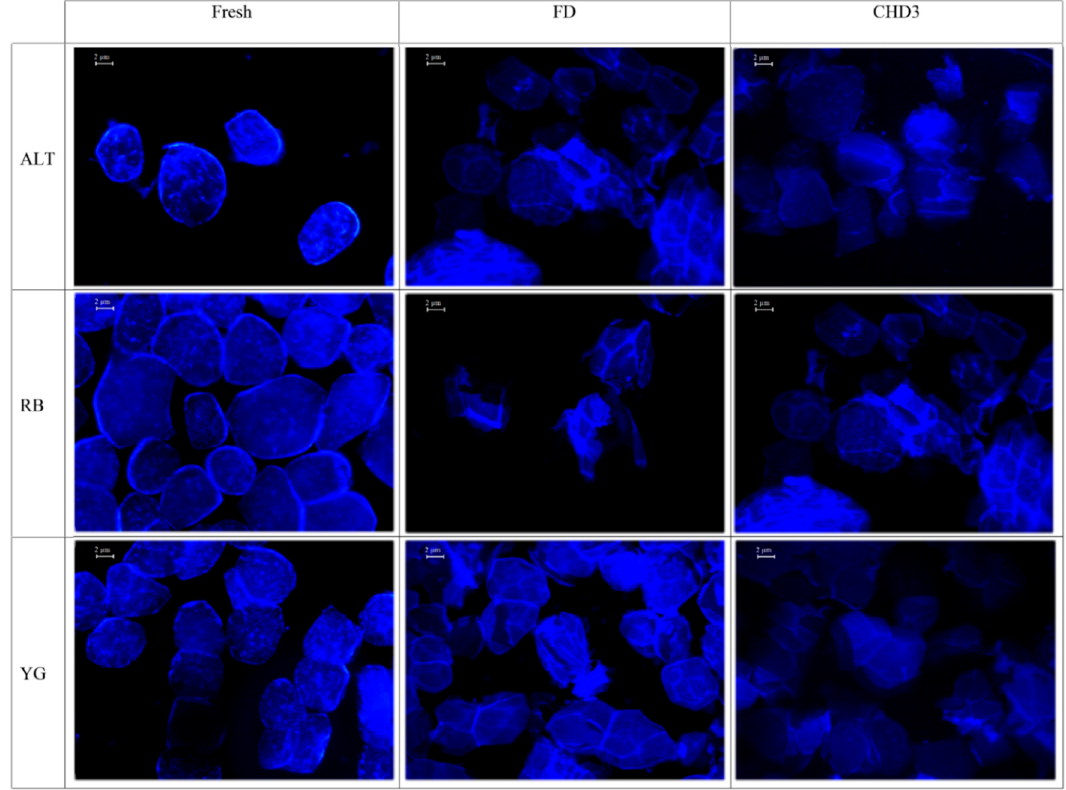
Figure 4. Fluorescent microscopy of three potato genotypes (rows) and three treatments (columns): fresh, freeze-dried (FD) and conductive hydro-drying (CHD3) at 175× magnification. For all cultivars, freshly processed potatoes show relatively intact starch granules with smooth walls (column 1) whereas FD (column 2) and CHD3 (column 3) showed granules with relatively less integrity and some cracking.